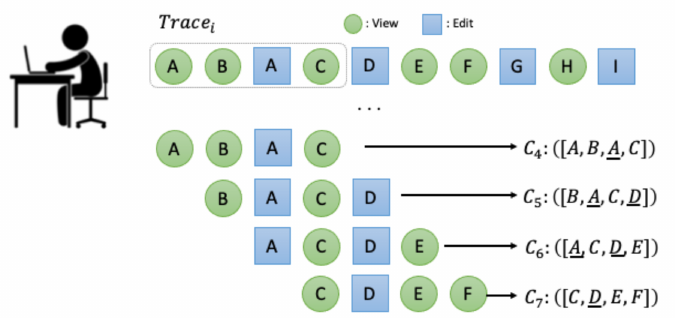
Figure 6. Example contexts created by setting the size of the sliding window to 4 based on a CERNN